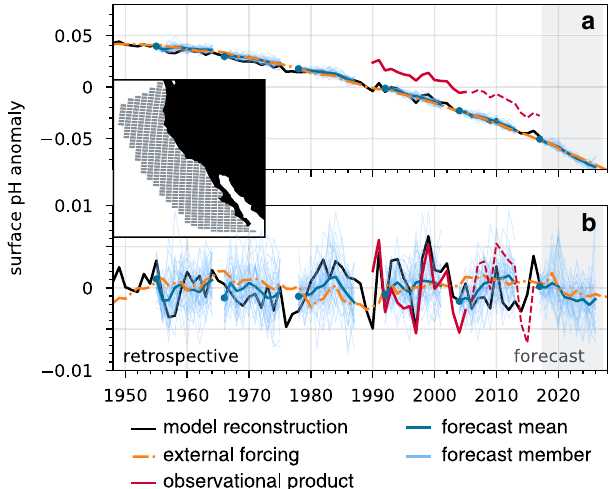
Fig. 1 Experimental design of the decadal prediction system. a Trended and b detrended, area-weighted annual surface pH anomalies for the (black) reconstruction, (red) observational product, (orange) Community Earth System Model Large Ensemble (CESM-LE) ensemble mean, and (blue) CESM Decadal Prediction Large Ensemble (CESM-DPLE) decadal forecasts initialized in 1954, 1965, 1977, 1991, 2003, and 2017 (other initializations were omitted for visual clarity). The dark blue line is the ensemble mean forecast, and thin blue lines are the individual 40 forecasts. The blue dots do not sit exactly atop the black line due to the rapid divergence of forecasts away from initialization within weeks. The dashed red lines denote when the model loses observed variability in atmospheric CO 2 forcing (Supplementary Fig. 1A). The inset shows the California Current Large Marine Ecosystem bounds, over which all area-weighted analyses are